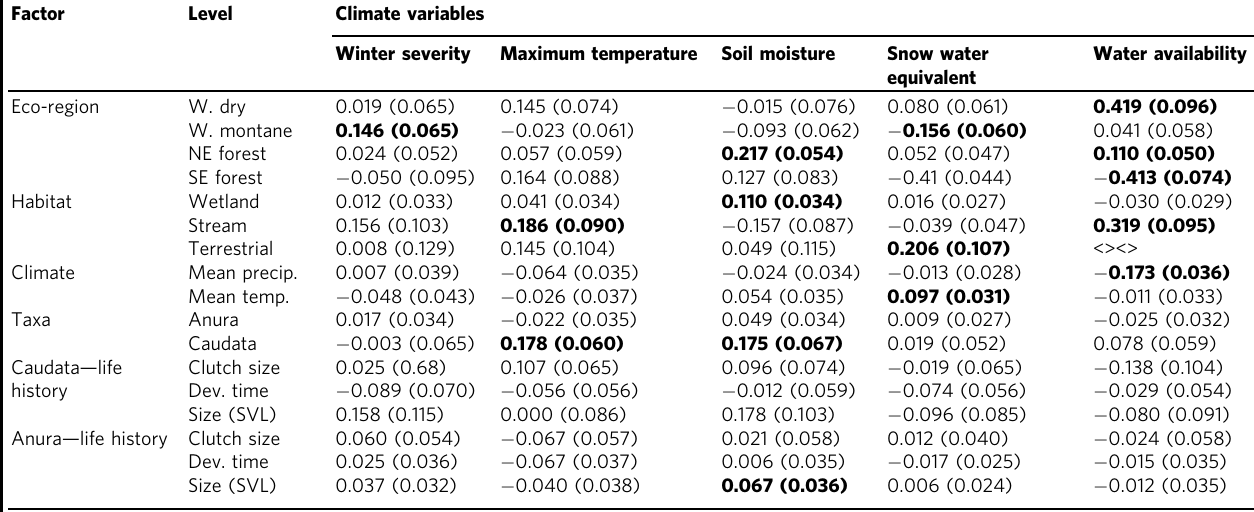
Table 1 Estimated Relationships between annual conditions and species turnover Factor Level